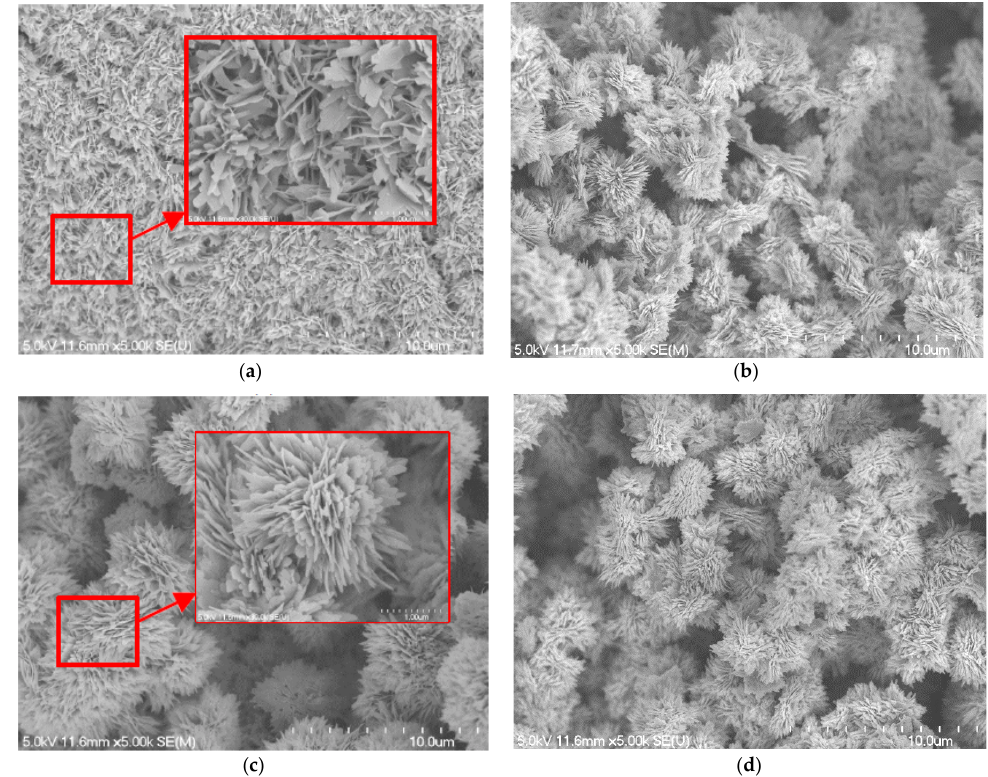
Figure 4. SEM images of blackening copper foam at 5 k magnifications: ( a ) 2.5 mol/L; ( b ) 3.0 mol/L; ( c ) 3.5 mol/L; ( d ) 4.5 mol/L.